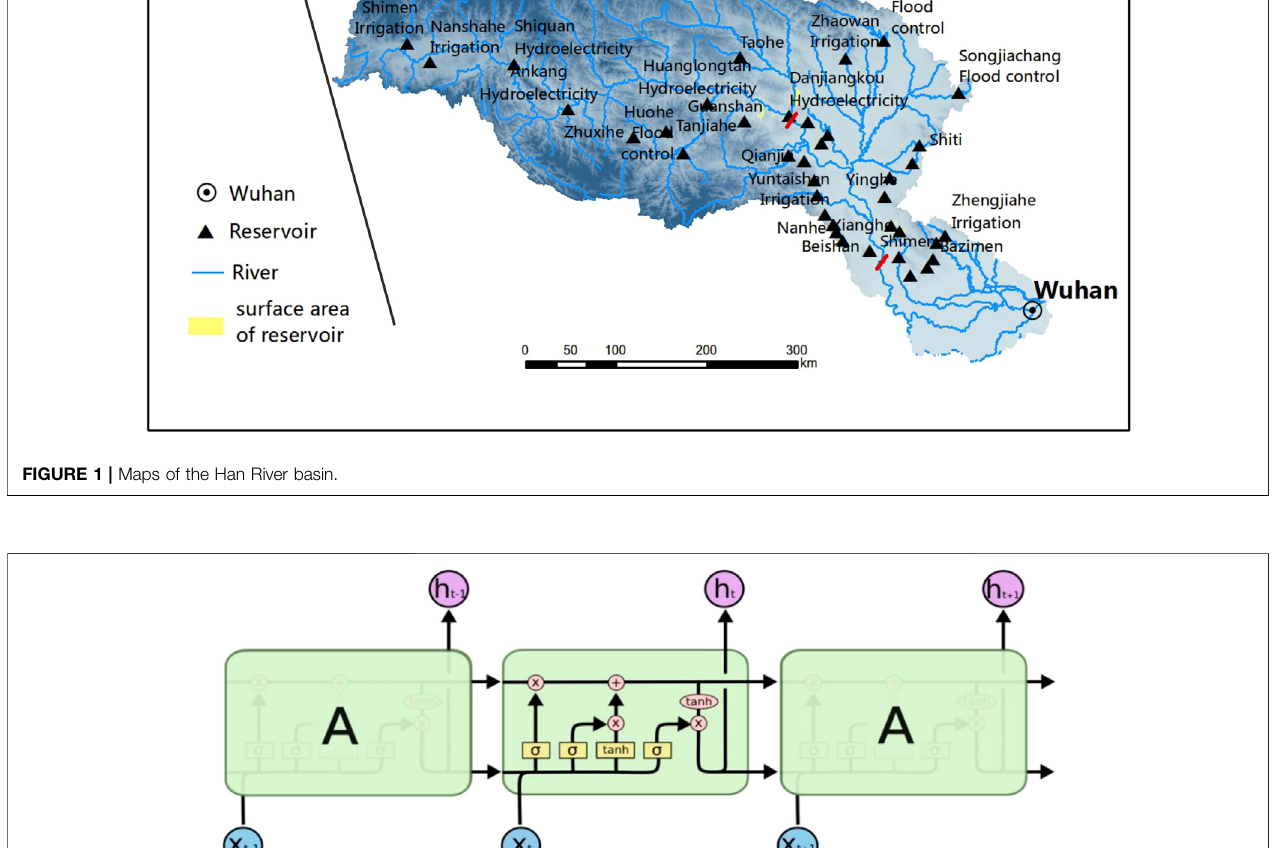
Frontiers in Physics |